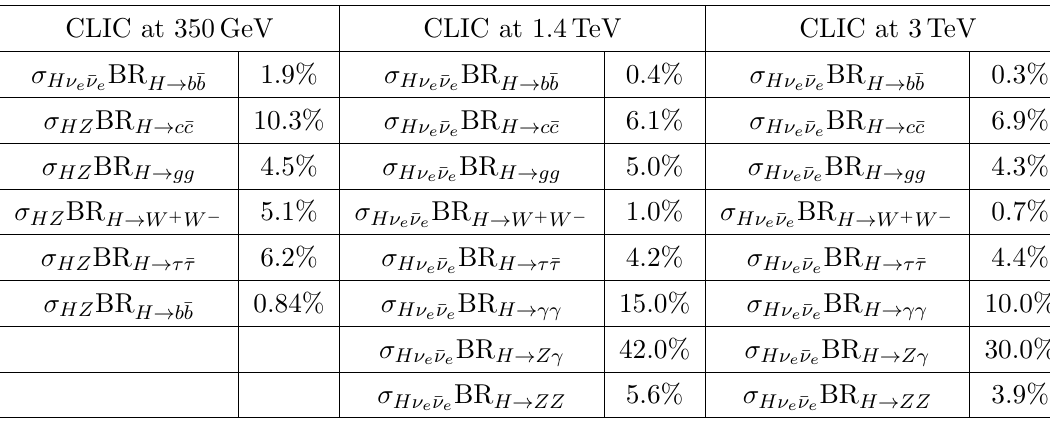
Table 2 . Summary of projected statistical precisions for Higgs measurements from ref. [54] that we use in our (cid:12)t. Observables sourced elsewhere are discussed in the